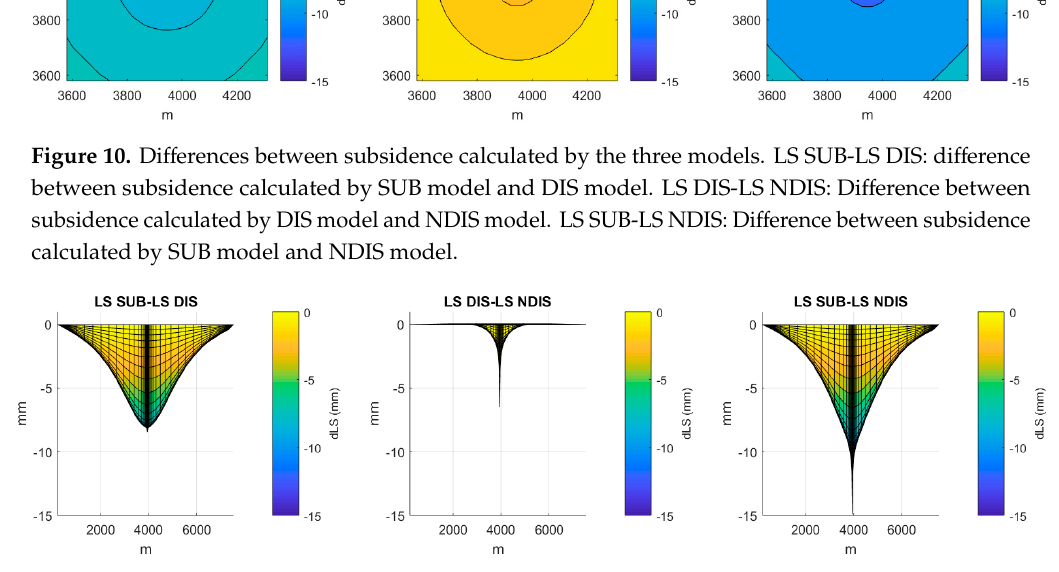
Figure 11. Differences between subsidence calculated by the three models at the profile passing through the center of the grid.